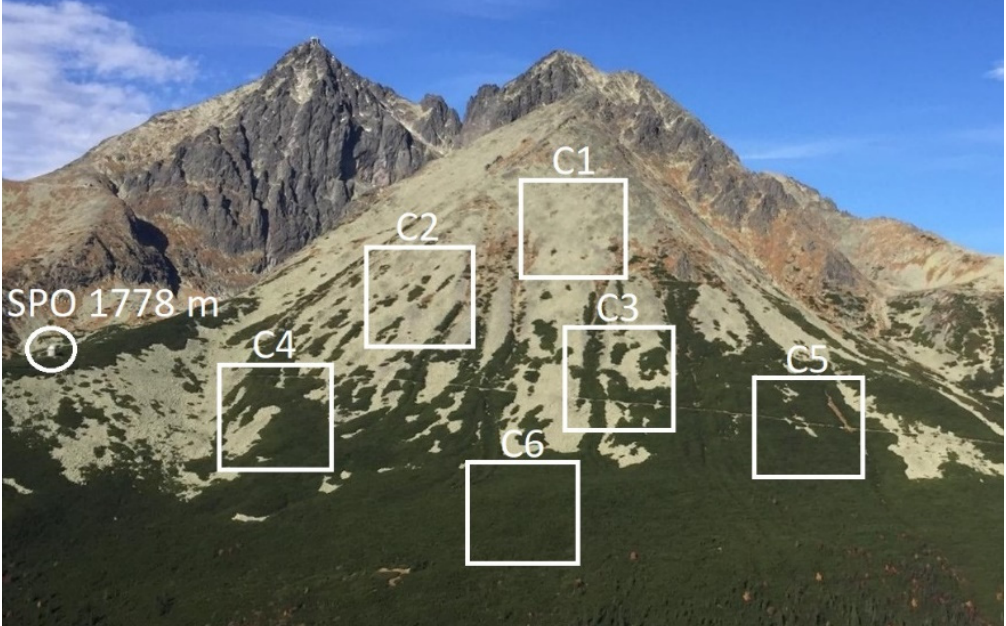
Figure 2. The photography of the studied region near Skalnaté Pleso Observatory (SPO, 1778 m a.s.l.) illustrates the densities in the P. mugo classes (C1–C6) described in Table 3. The white squares are for illustrative purposes only and do not correspond with the MODIS pixels. Table 3. Classification of pixels with P. mugo into density classes based on their average NDVI values. NDVI Class